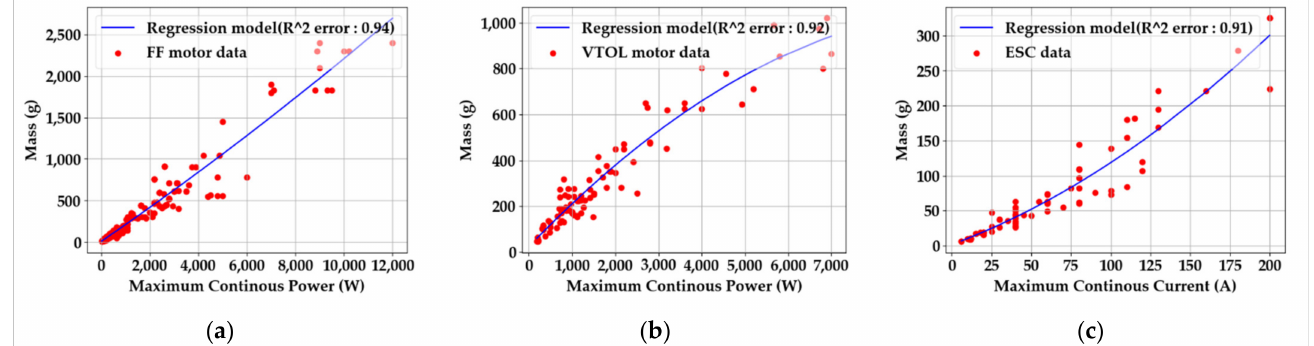
Figure 6. Motor and ESC regression model: ( a ) the model for FF motor sizing; ( b ) for VTOL motor sizing; ( c ) for ESC sizing. The motor data are from the T-motor [21], Scorpion motor [23], Hacker motor [24], and ESC data from the Hobbywing [25]. The accuracy of the model was measured by the R -squared error, and the accuracy was high at 0.94, 0.92, and 0.91, respectively. The regression model was generated by data from approximately 200 FF motors, 100 VTOL motors, and 70 ESCs. The unit of power is expressed in watts (W), the current in amperes (A), and the mass in grams